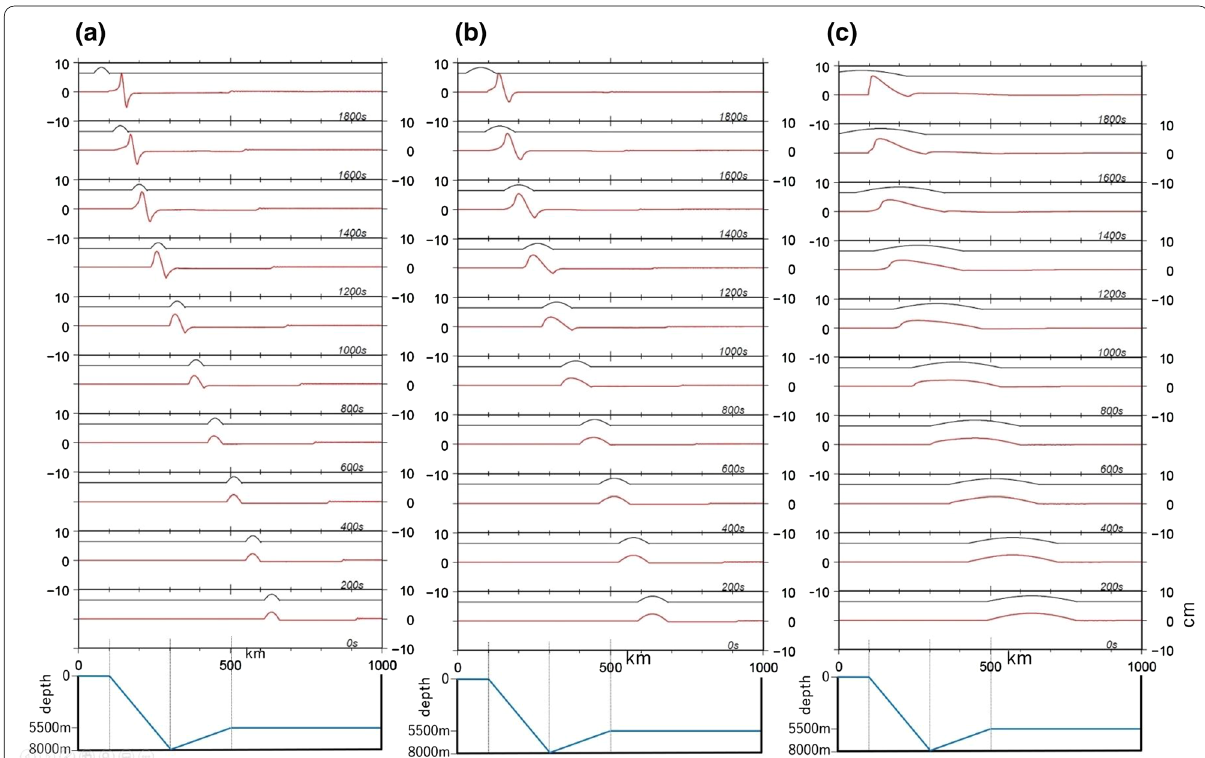
Fig. 5 Ten snapshots (red lines) of one-dimensional air–sea coupled wave simulations for three atmospheric pressure pulses, half-wavelengths of 50 km ( a ), 100 km ( b ), and 300 km ( c ). Black waveforms are the atmospheric pressure changes with the maximum amplitude of 2 hPa for each snapshot. The bottom shows the simple bathymetry used in this simulation